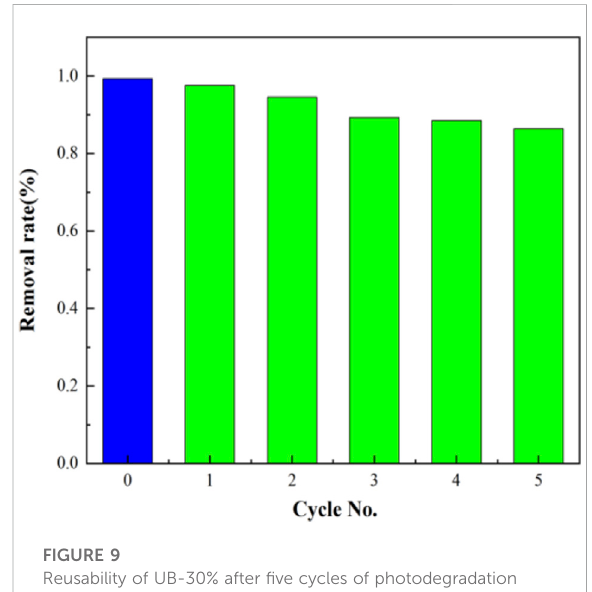
FIGURE 9 Reusability of UB-30% after fi ve cycles of photodegradation of RhB.